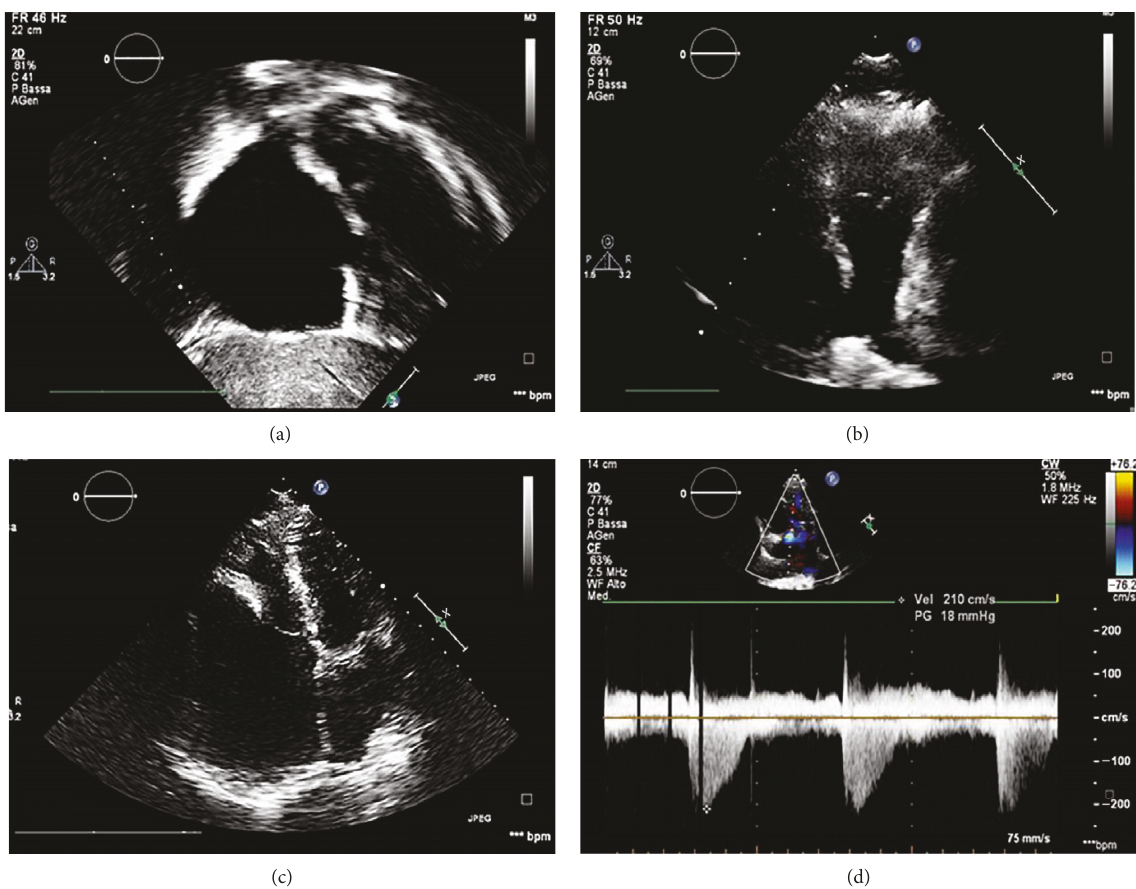
Figure 2: (a) Subxiphoid long-axis view showing abnormal dilation of the right atrium and intact interatrial septum. (b) Modi fi ed parasternal short-axis view showing the regular diameter of the pulmonary trunk. (c) Apical 4-chamber view demonstrating the compression of the right ventricle from the right atrium. (d) CW Doppler of tricuspid